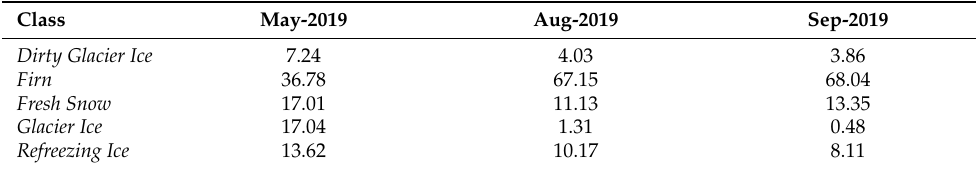
Table 5. Area statistics in % for the months of May, August and September of 2019.